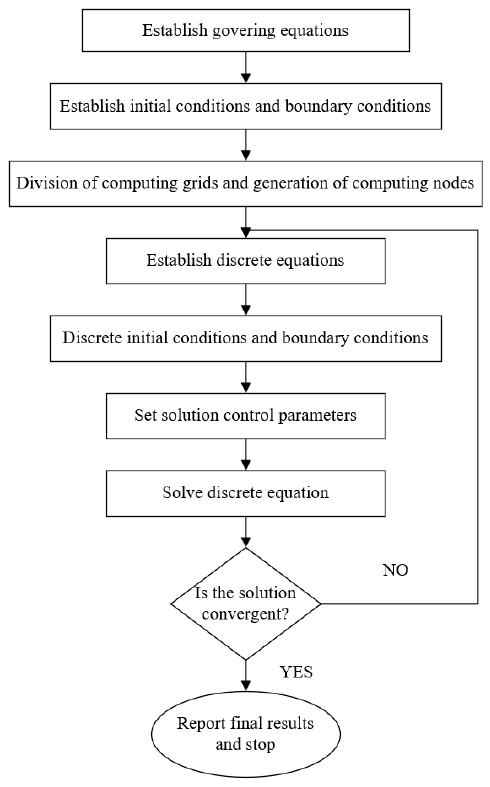
Figure 3. The working flow chart of computational fluid dynamics